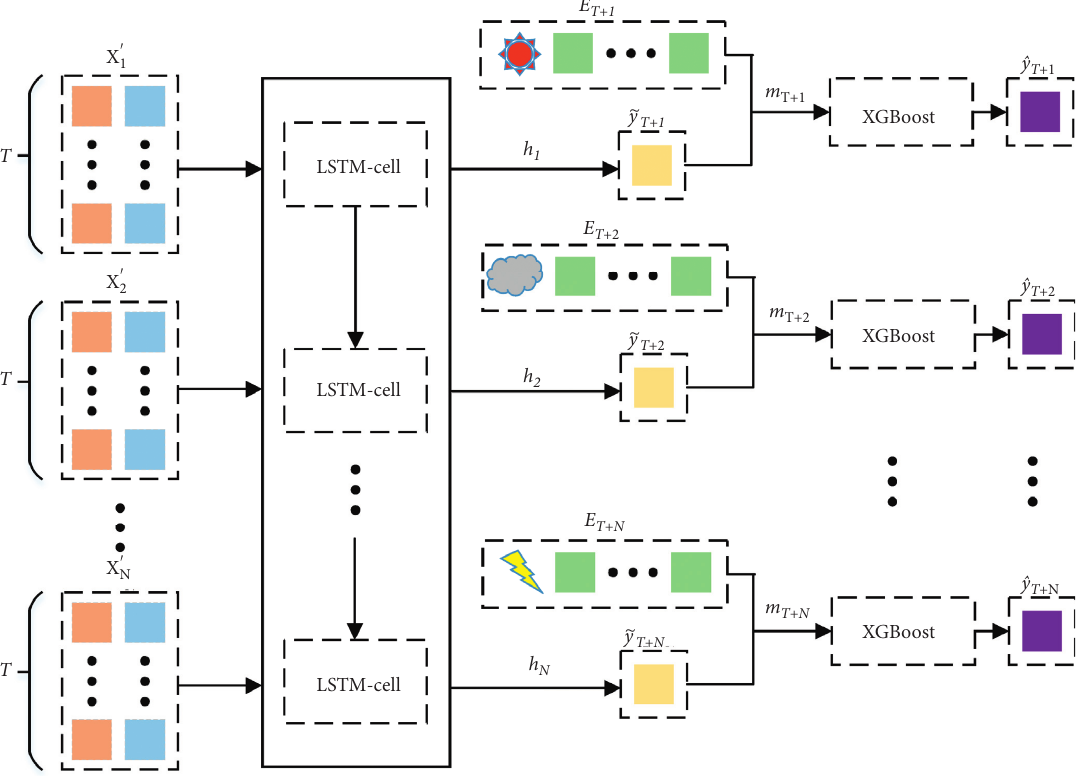
Figure 4: The structure of the proposed LSTM-XGBoost